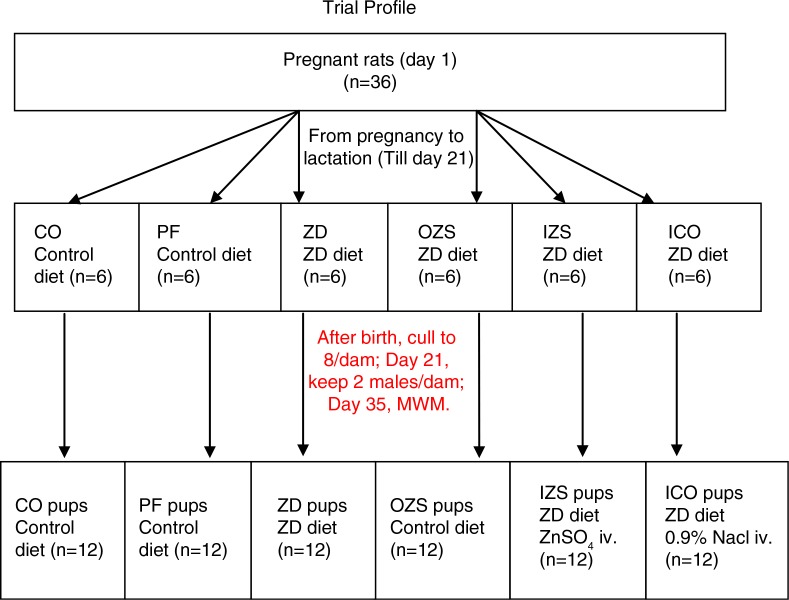
Trial profile demonstrating number of dams and pups in each group that were fed with Zn-deficient diet (Zinc 2 µg/g) or control diet (Zinc 25 µg/g). CO=control; PF=pair fed; ZD=zinc deprived; OZS=oral zinc supplementation; IZS=injection zinc supplementation; ICO=injection control.